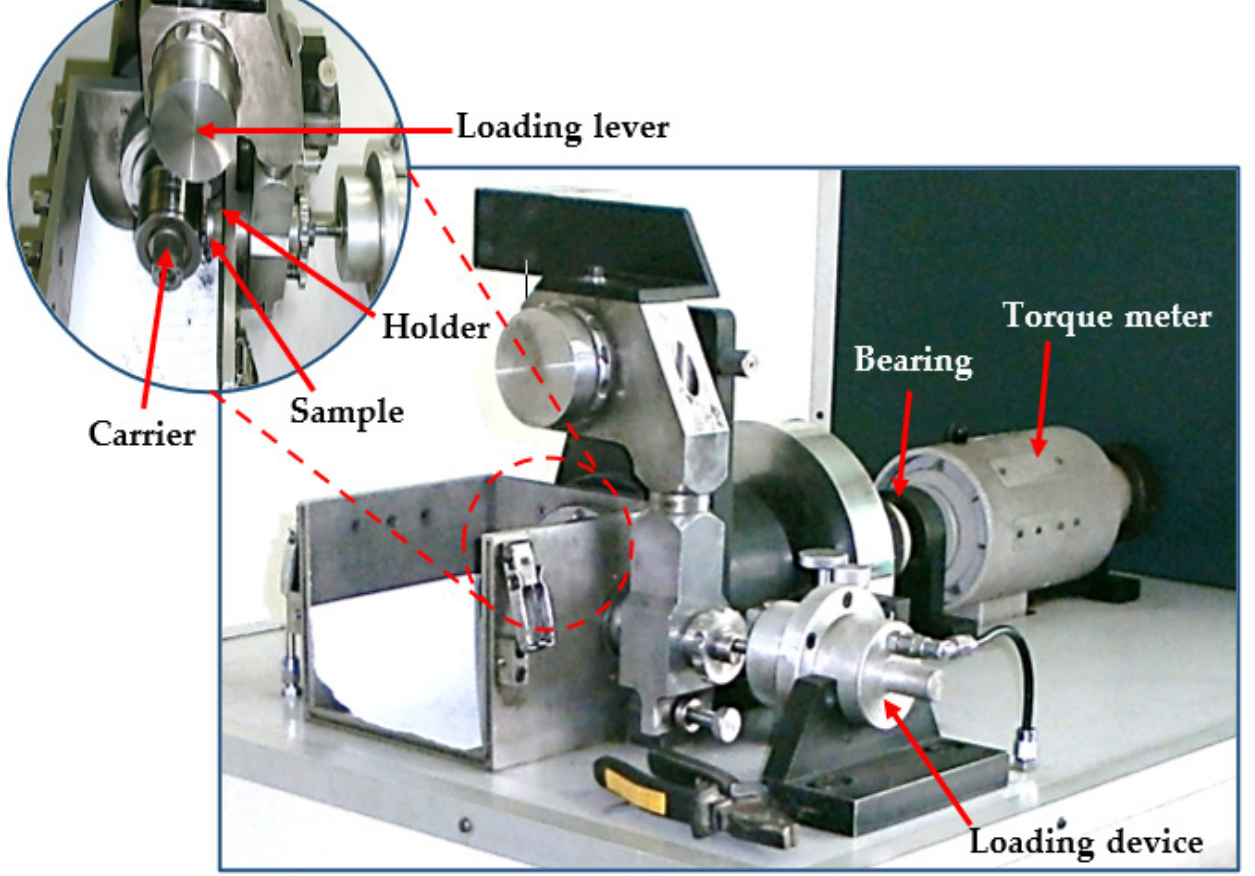
Figure 2. Block-on-ring test rig of the model tribometer.